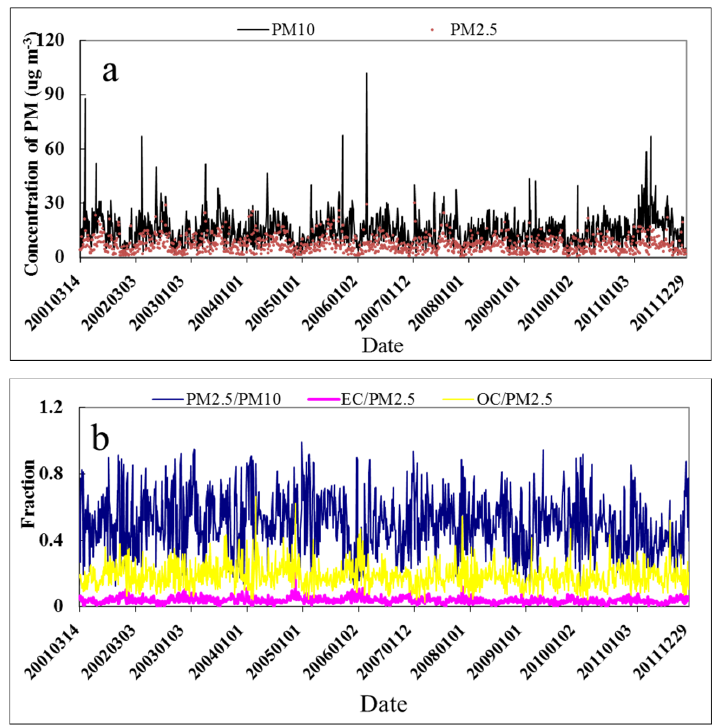
Figure 4. Characteristics of aerosols ( a ) Concentrations of PM 2.5 and PM 10 . ( b ) Fractions of PM 2.5 /PM 10 , EC/PM 2.5 , OC/PM 2.5 ) at the WIMO1 site from 2001 to 2011.